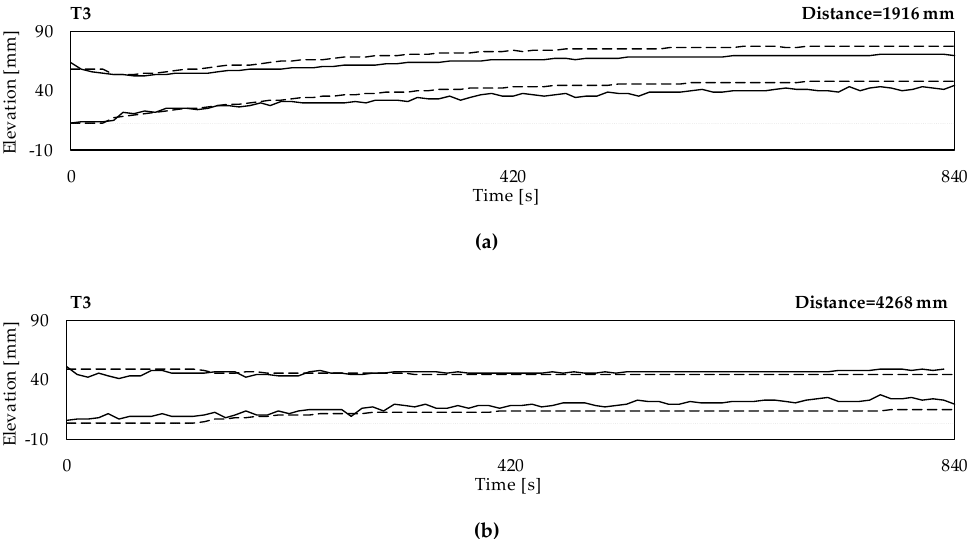
Figure 7. Longitudinal bed and water profiles for the experiment T3 obtained experimentally (continuous) and numerically (dashed) at ( a ) 0 s, ( b ) 170 s, ( c ) 340 s, and ( d ) 680 s. The horizontal axis represents the stream-wise distance from the inlet, whereas the vertical coordinates were measured with respect to the initial bed surface elevation at the channel outlet. The longitudinal bed profile at 0 s is represented by the gray line. Flow is from right to left.